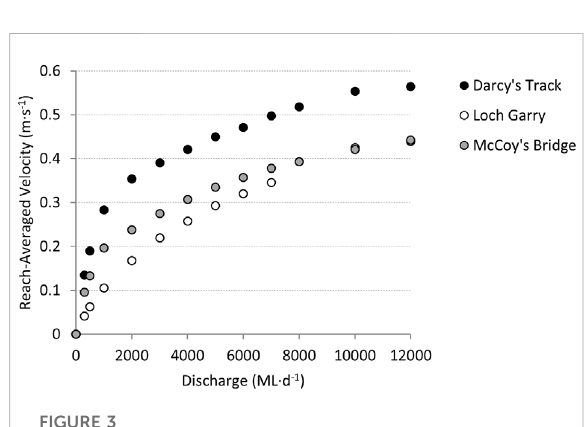
FIGURE 3 ‘ Rating curves ’ relating discharge to reach-averaged velocity for the three hydraulic models used in this